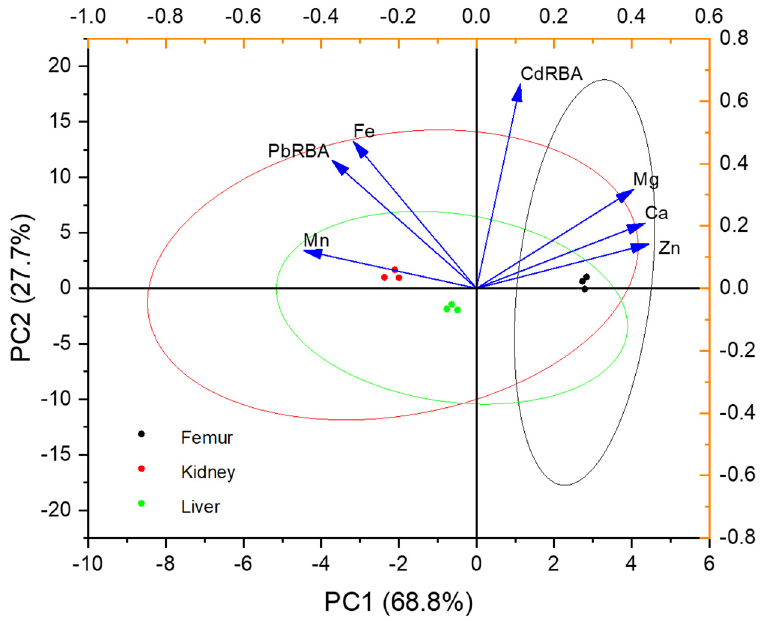
Figure 5. Principal component analysis of various mineral elements and metal relative bioavailability in different mouse organs.